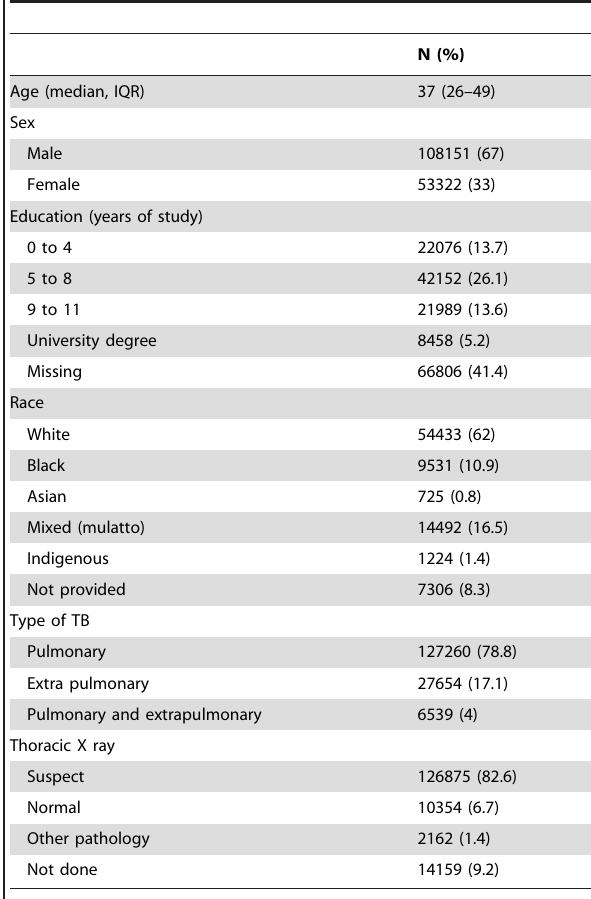
Table 1. Characteristics of new tuberculosis cases in 6 States of Brazil between the years of 2003 and 2008 (n =161481).